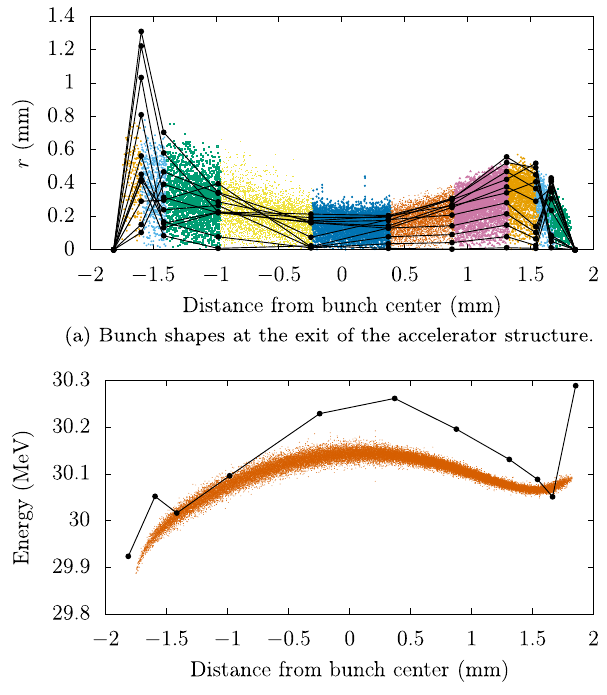
FIG. 11. Beam dynamics for the SPring-8 rf gun injector system with focusing fields calculated by the multiple beam envelope equations.